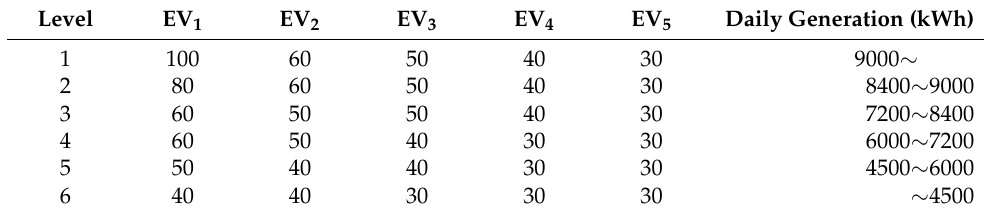
Table 4. EV guaranteed mitigation levels and guaranteed mitigation